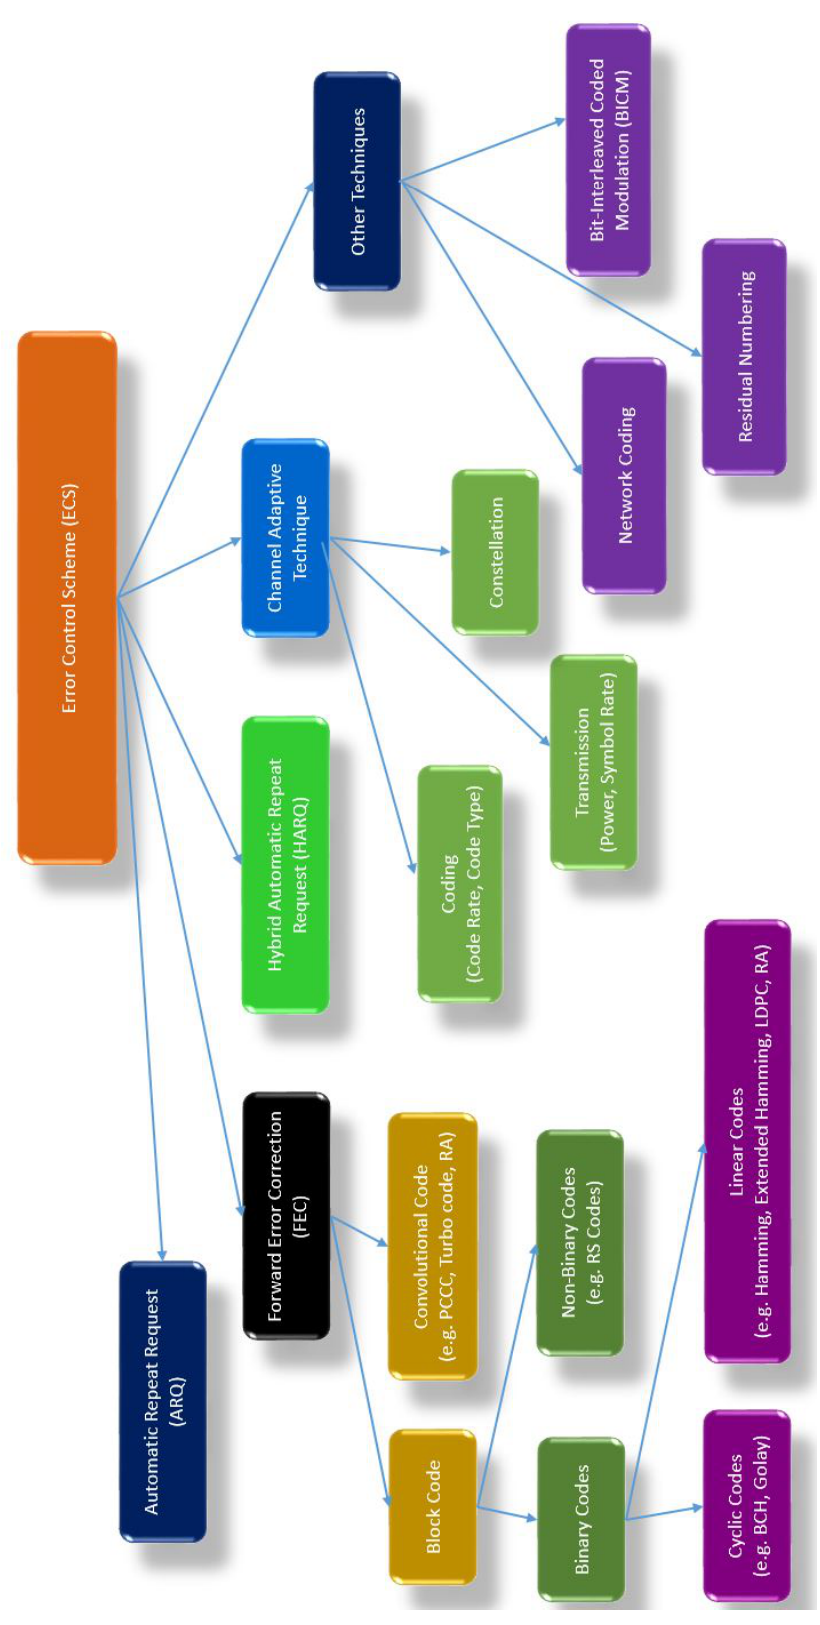
Figure 1. Classification of Error Correction Scheme (ECS) for Wireless Sensor Network (WSN) in error correction